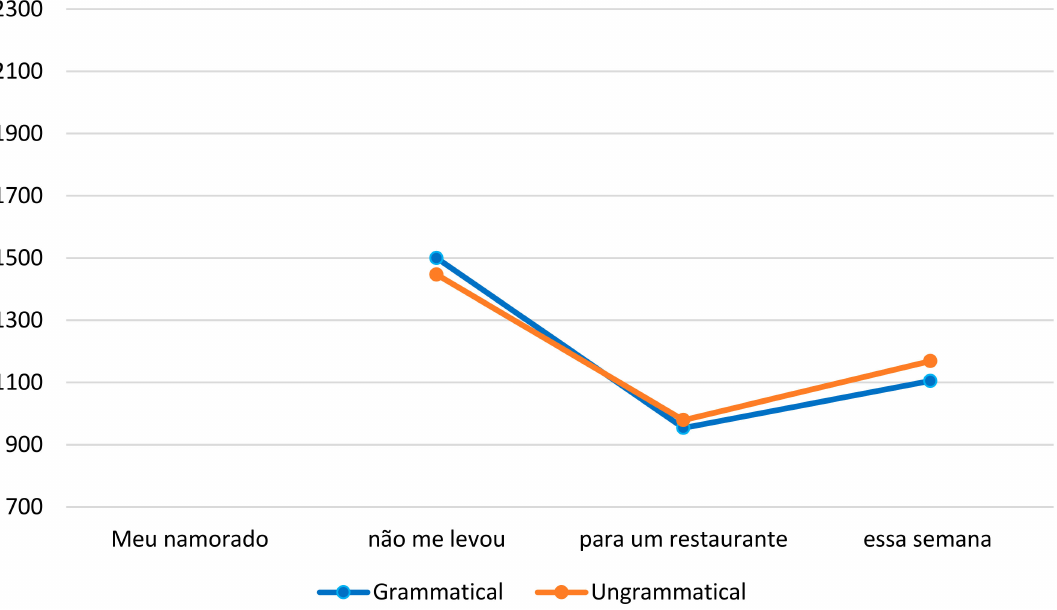
Figure 1. L1 Brazilian Portuguese (BP) speakers in the proclisis condition.